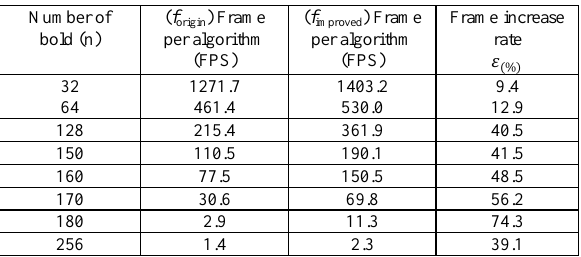
Tab 1: comparison of the frame performance of two algorithms